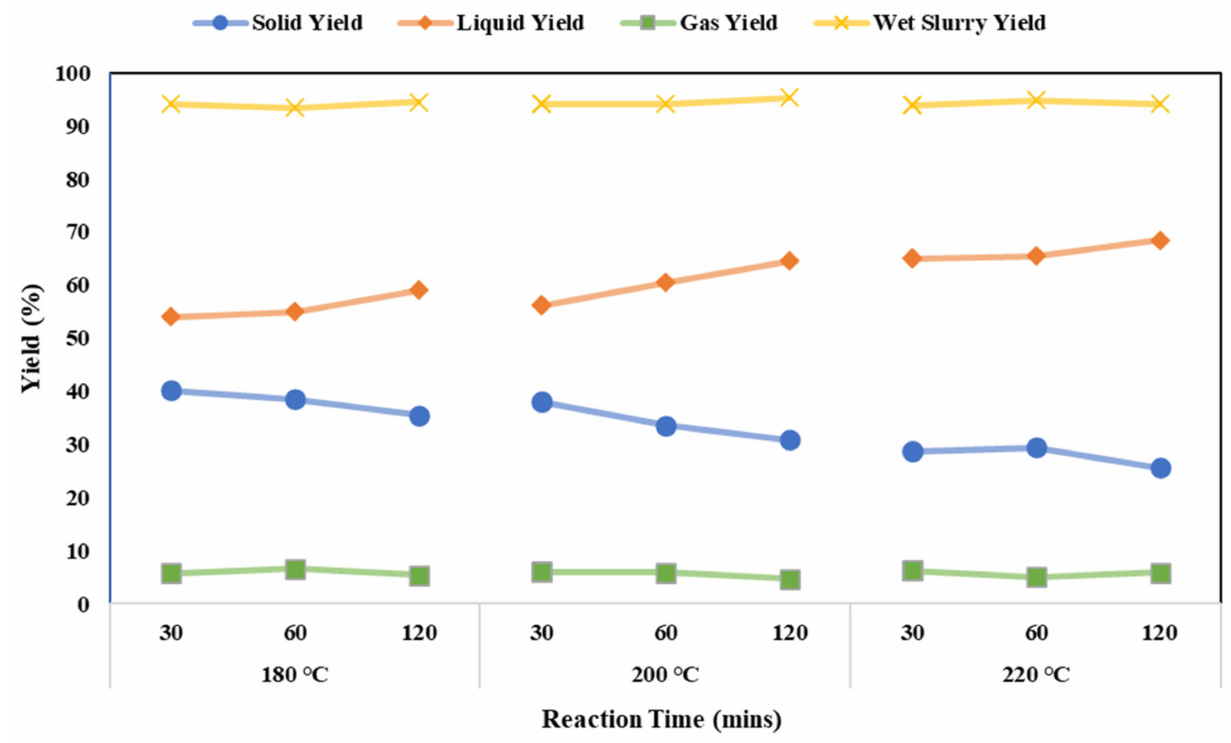
Figure 5. Effect of the reaction/residence time on the product yields in HTC.